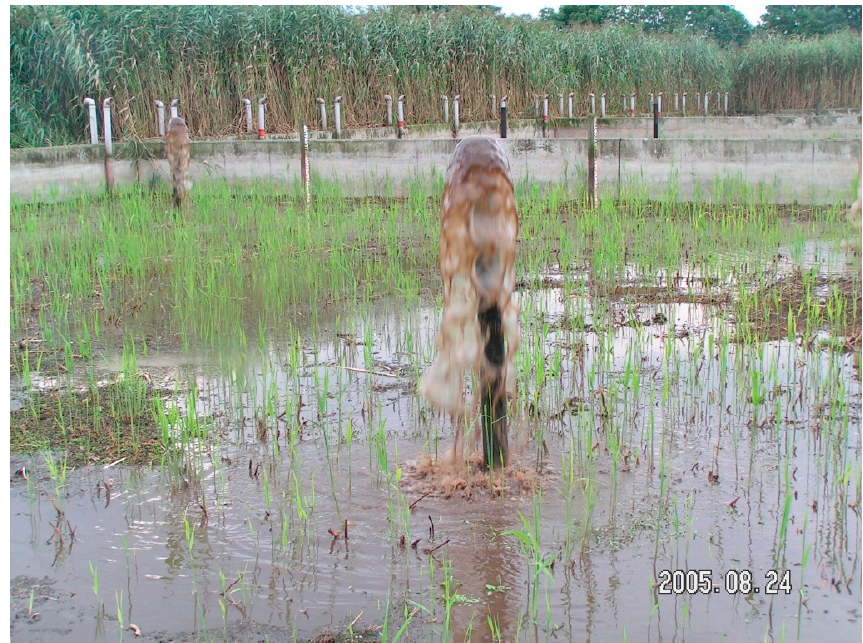
Figure 2. Vertical standpipes through which the liquid sludge is distributed over the entire surface of the bed. The picture shows a situation where a planted reed bed, after emptying, are being loaded again, and plants are regenerating from the rhizomes remaining in the growth layer (Photo: H. Brix).